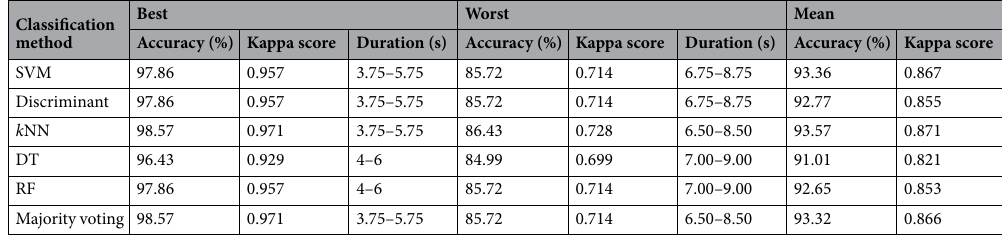
Best Worst Classification method